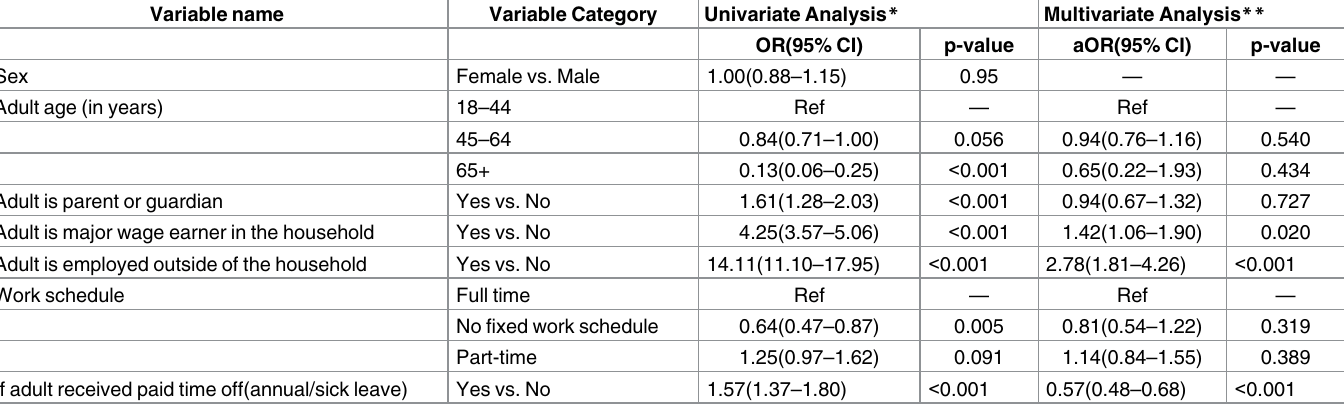
Table 5. Factors associated with adult household membersmissing work or losing pay during unplanned school closure, Harrison County School District, Mississippi, August